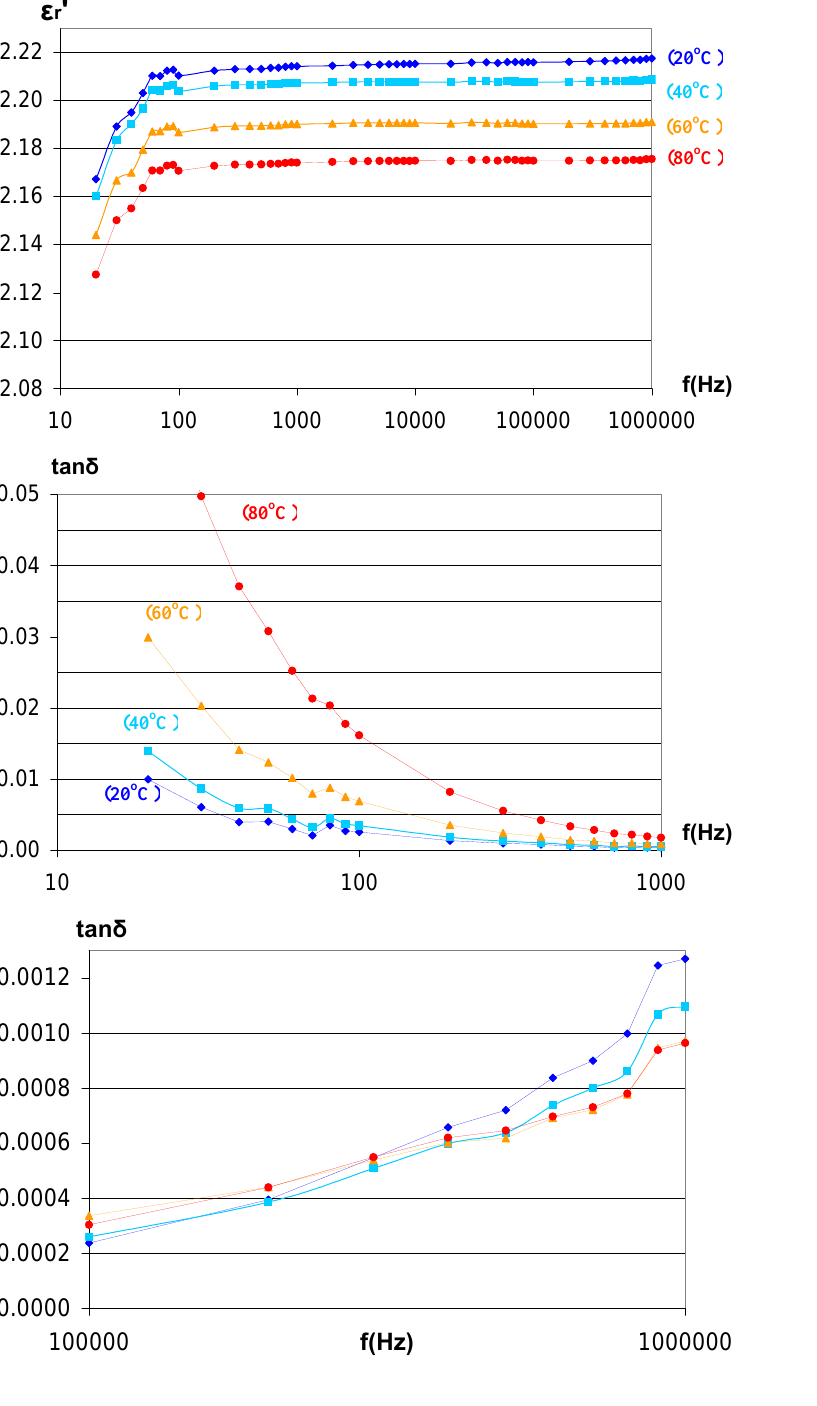
Figure 8. The dielectric spectroscopy data of the 68 power transformer oil samples classified in Group-III. (a) The average values for the relative dielectric constant ( ε ′ ) of all Group-III samples, as a r function of the operating temperature and frequency. (b) The average values of all loss tangent (tan δ ) data of the Group-III samples, as a function of operating temperature in the frequency range: 20Hz – 1kHz. (c) The average values of all loss tangent (tan δ ) data of the Group-III samples, as a function of operating temperature in the frequency range: 100kHz –